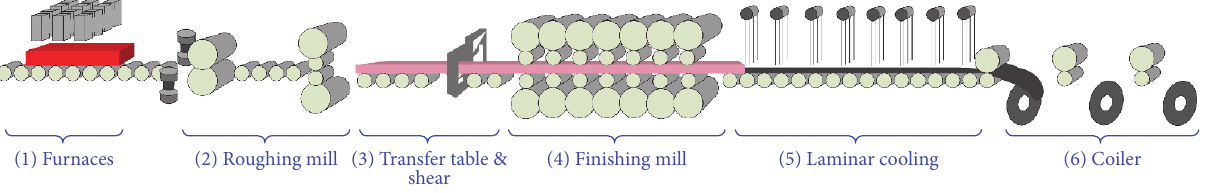
Figure 2: The schematic of HSMP.